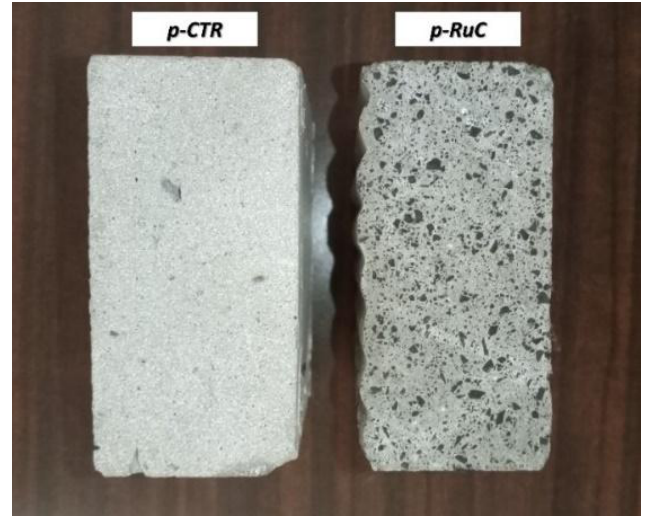
Figure 1. Cross-section of the 3D-printed slabs: p-CTR ( left ) and p-RuC ( right ).